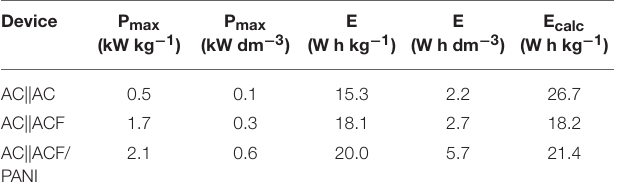
TABLE 4 | P and E obtained for the capacitors at a potential window of 1.6V in 0.5M H 2 SO 4 as